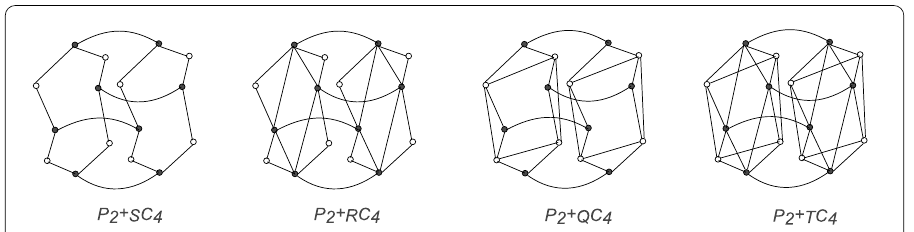
Figure 2 The graphs P 2 + S C 4 , P 2 + R C 4 , P 2 + Q C 4 and P 2 + T C 4